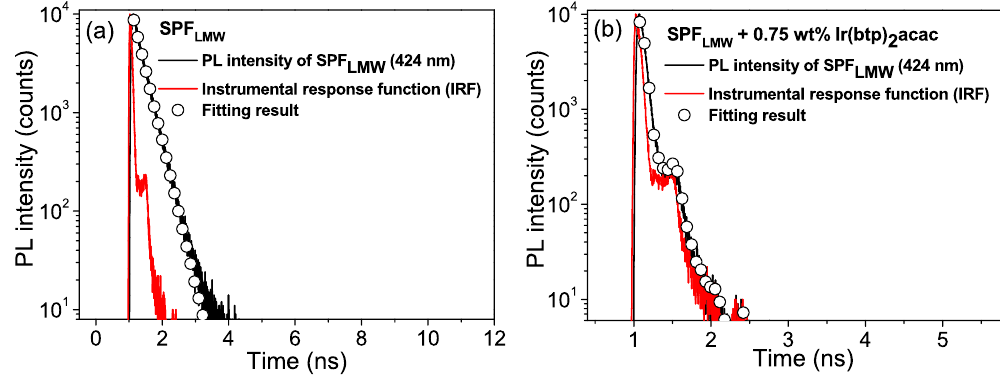
Figure 3. ( a ) TRPL of SPF LMW at 424 nm for optical excitation at 387 nm, that of Ir(btp) 2 acac doped SPF LMW is provided in the ( b ). The open circles are single exponential fits and average fall times (over three samples) of 293 ps and 36 ps can be obtained for pure and Ir(btp) 2 acac doped SPF LMW , respectively. These TRPL measurements were carried out in device geometry with the structure: ITO/PEDOT:PSS/emitting layer/TPBI/